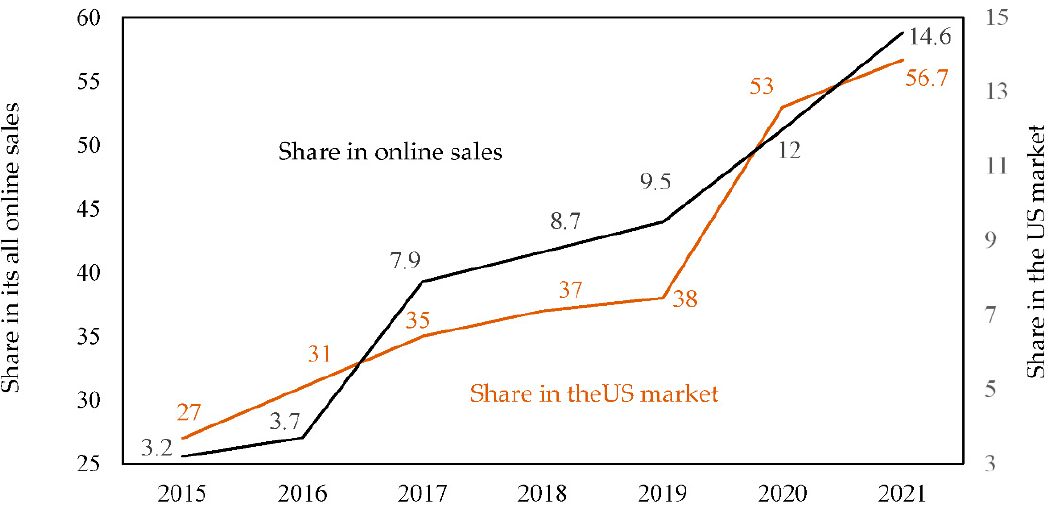
Figure 9. Trends in Amazon’s apparel sales share (2015 to 2021): percentage. Sources: [70–76].